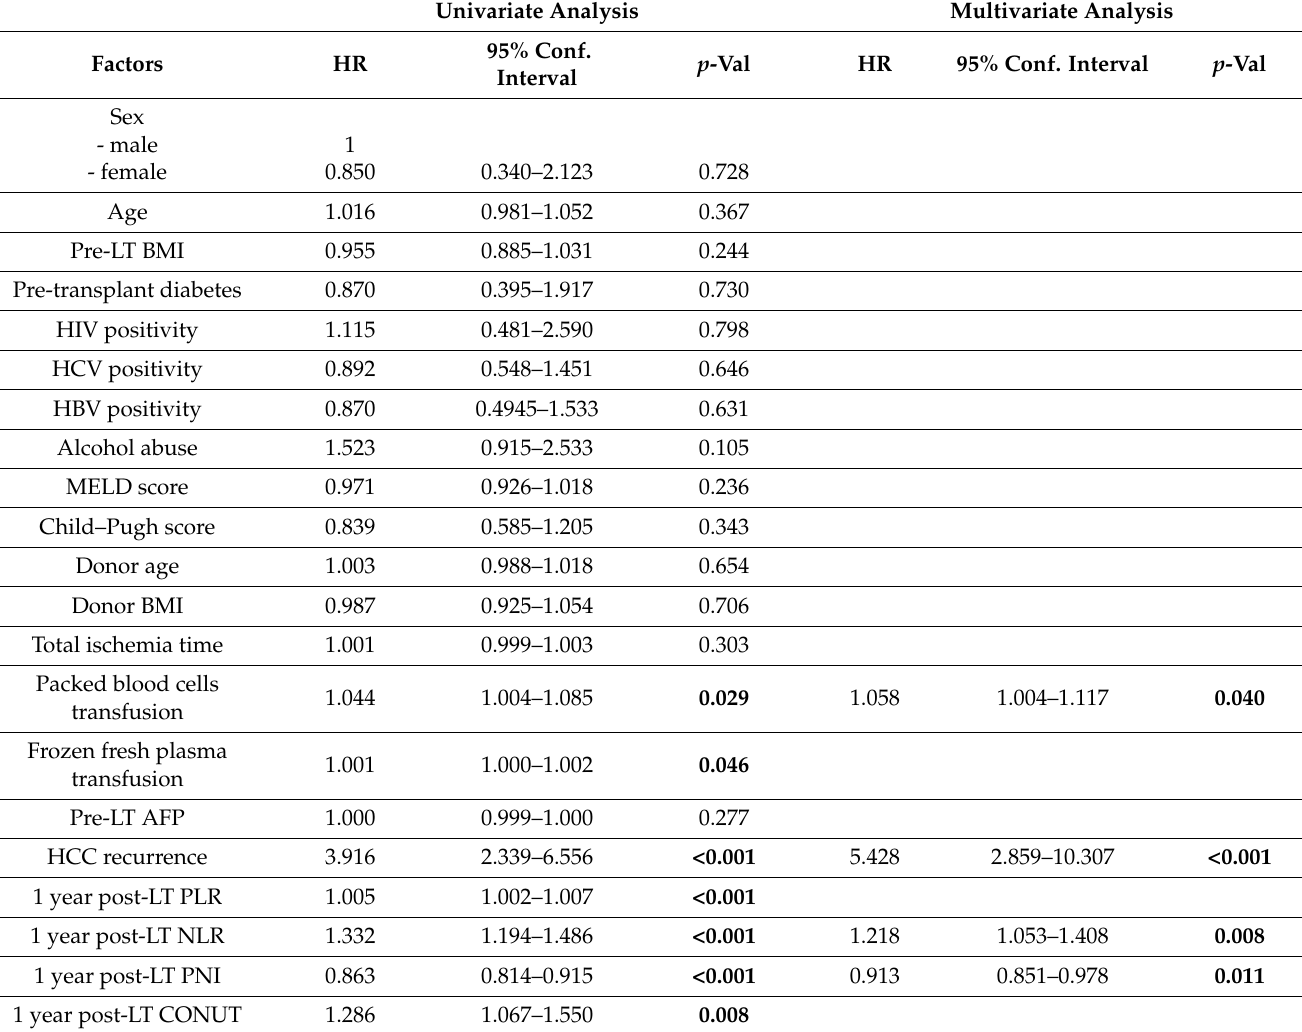
Table 3. Univariate and multivariate Cox analysis of prognostic factors for OS, in subgroup analysis of patients with overall survival (OS) > 1 year and no early HCC recurrence ( n =